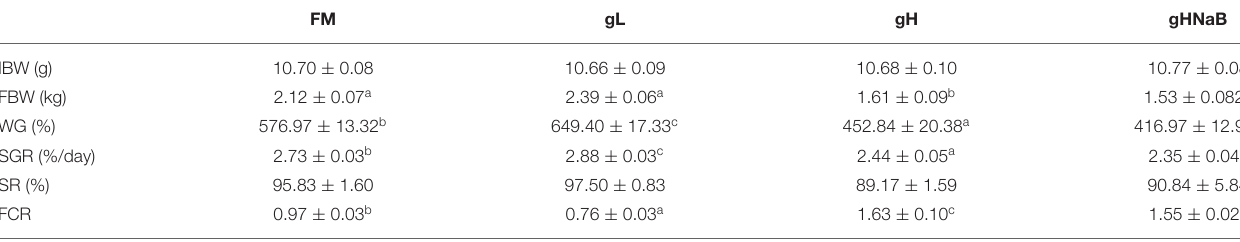
TABLE 3 | Growth parameters and feed utilization of juvenile hybrid grouper fed the experimental diets for 8